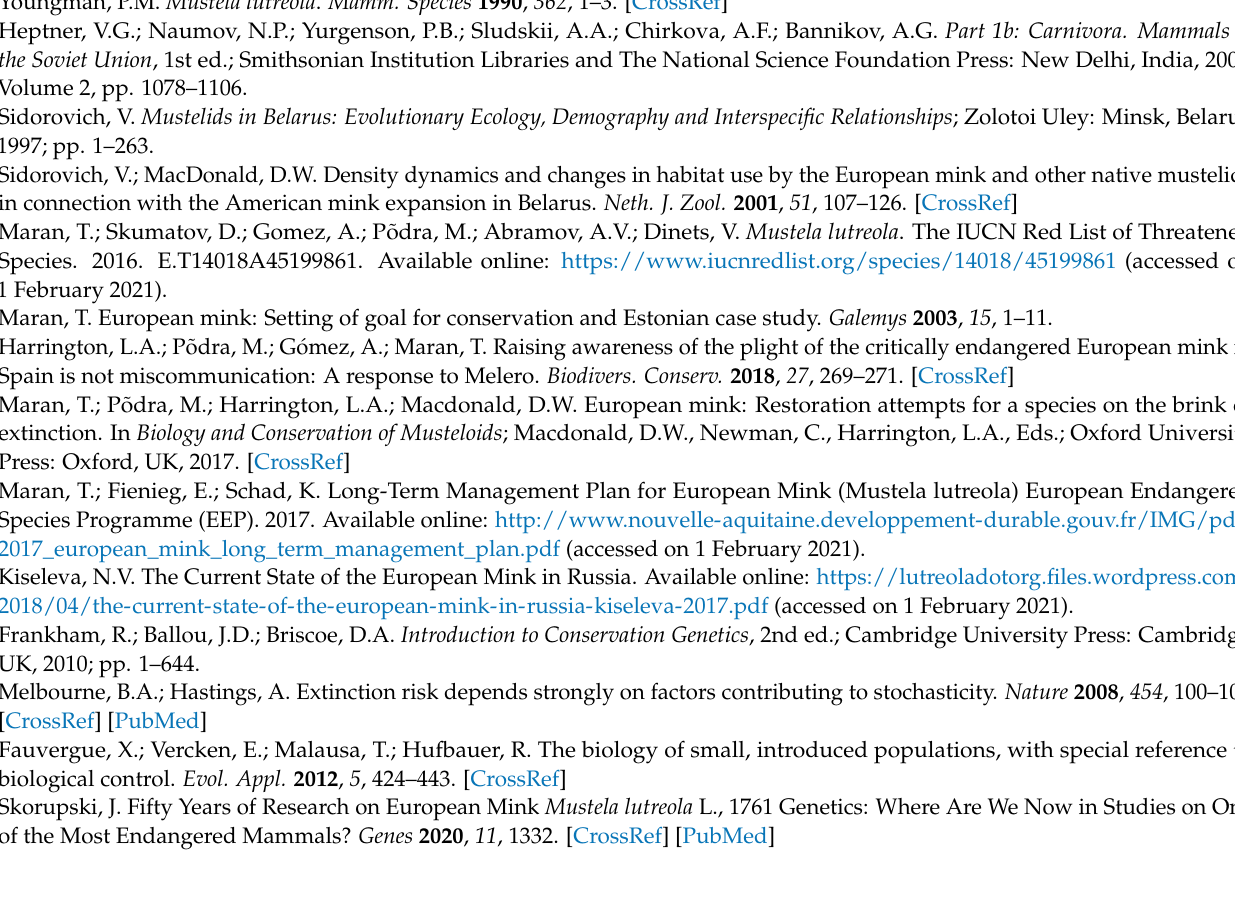
subunit in Mustela lutreola (dashes indicate Watson-Crick base pairing; red asterisks indicate non- canonical G-U pairs; the 5 (cid:48) -end is marked with a green circle and the 3 (cid:48) -end with a red circle), Figure S5: Predicted secondary structure of the mitochondrial ribosomal RNA of the small ribosomal subunit in Mustela lutreola (dashes indicate Watson-Crick base pairing; red asterisks indicate non- canonical G-U pairs; the 5 (cid:48) -end is marked with a green circle and the 3 (cid:48) -end with a red circle), Figure S6: Multiple alignment for the 43 mtDNA sequences of Mustela lutreola deposited in the GenBank [23] aligned to the MW148603 reference sequence, reported in this